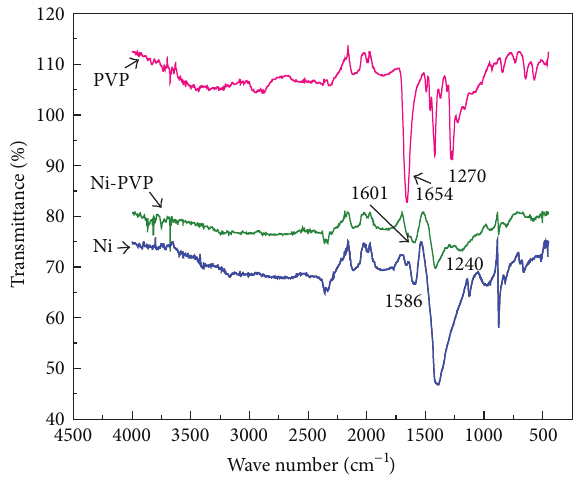
Figure 6: The infrared spectra of synthesized powders of pure PVP, Ni-PVP and Ni powders.